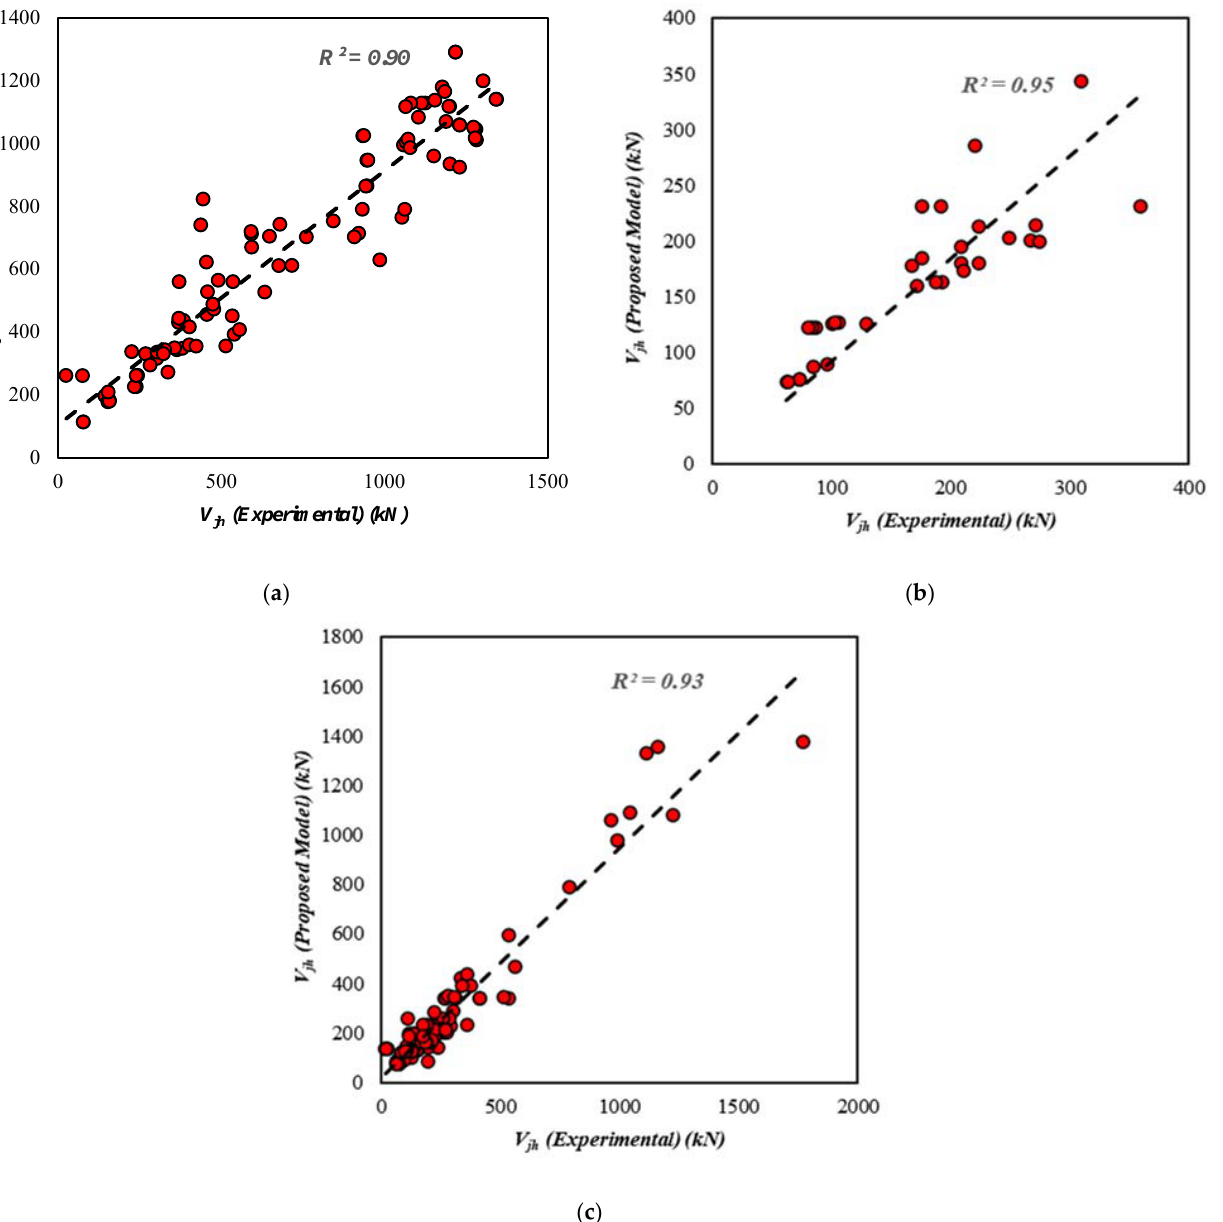
Figure 5. Results for the shear strength of the exterior joint ( a ) training data, ( b ) validation data, ( c ) all data.